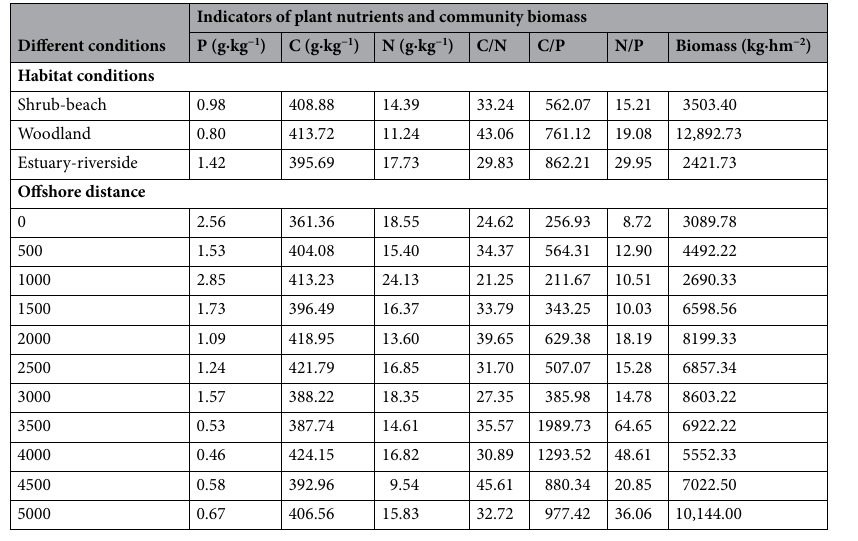
Table 3. Variation characteristics of plant nutrients and community